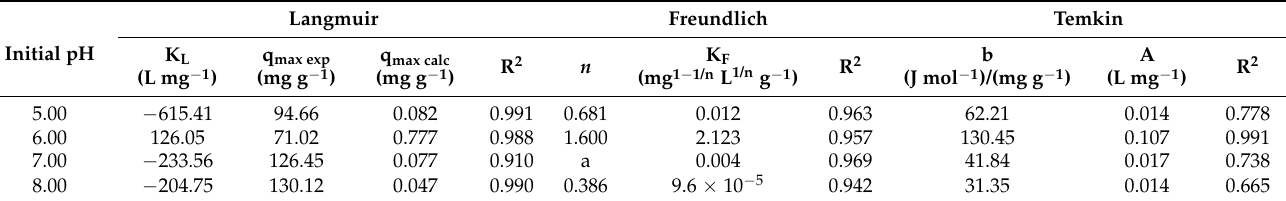
Table 2. Fitting parameters of the adsorption isotherms.